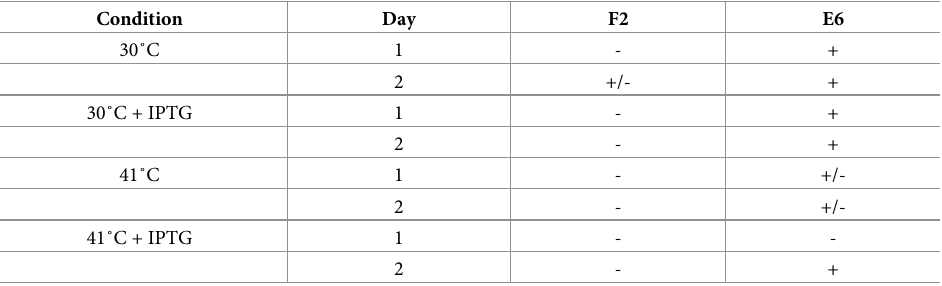
(-): PHA granules were absent; (+/-): PHA granules were found in some, but not all cells; (+): PHA granules were found in nearly every cell. Plasmid pDKF2 contains phaC